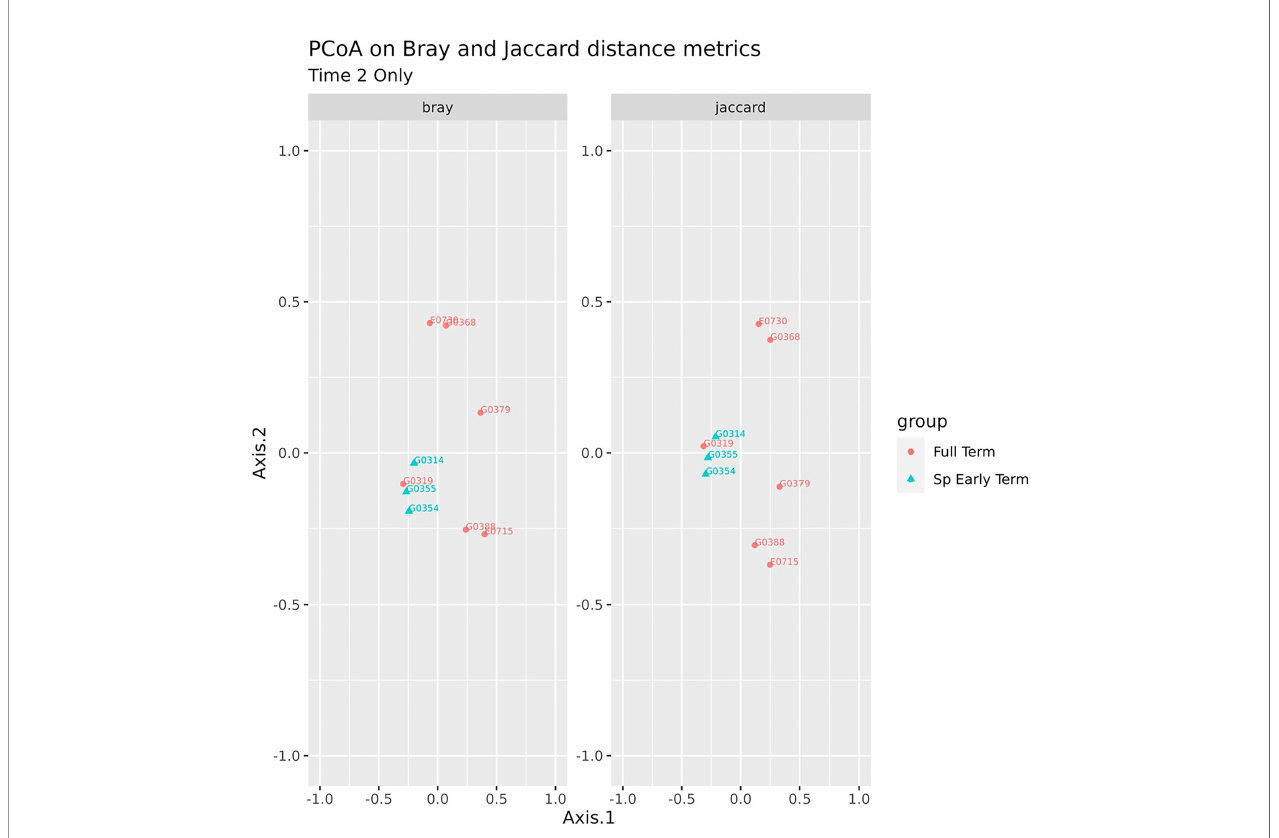
FIGURE 3 | Beta diversity of subgingival microbiome at Time 2 according to delivery time status.